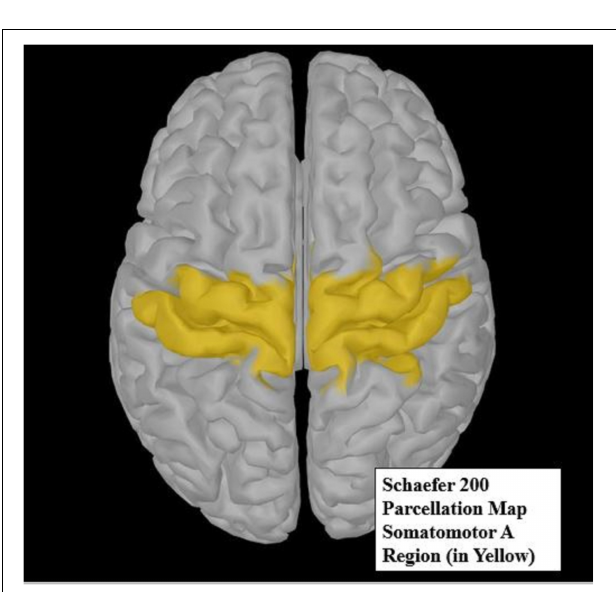
FIGURE 4 | The yellow highlighted region of the Schaefer 200 parcellation map (Schaefer et al., 2018) represents the somatomotor A region of interest (ROI). This ROI was used for source